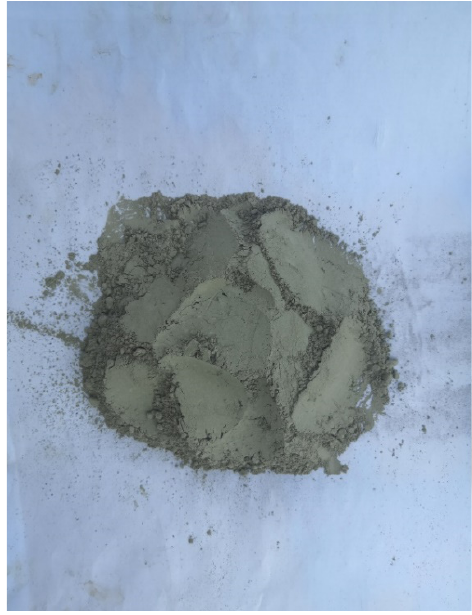
Table 3. Chemical composition of CFB-BA.